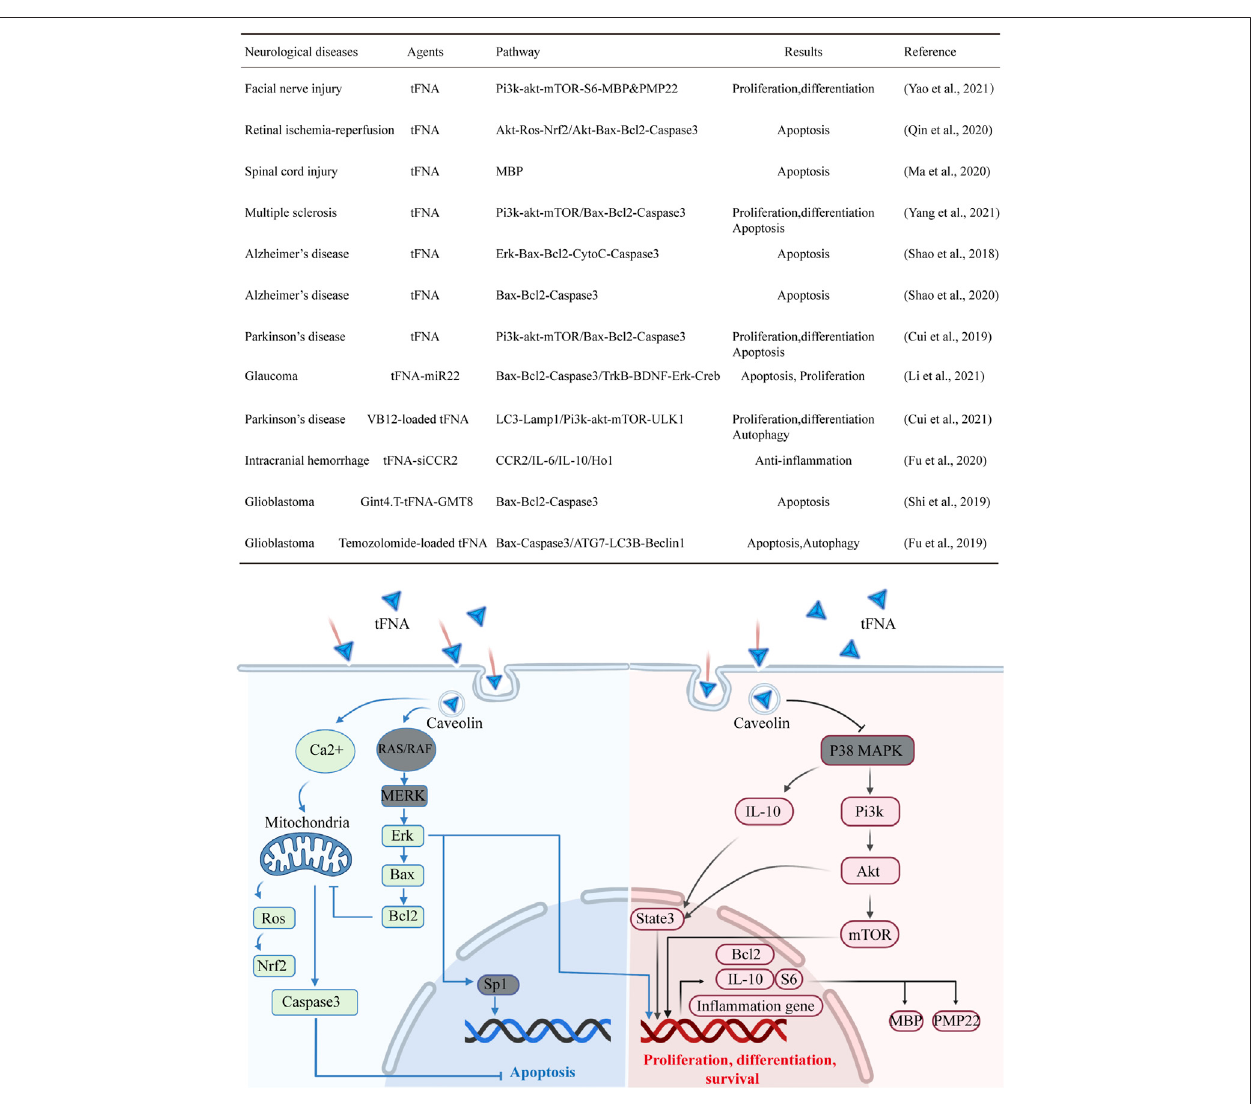
Frontiers in Bioengineering and Biotechnology |